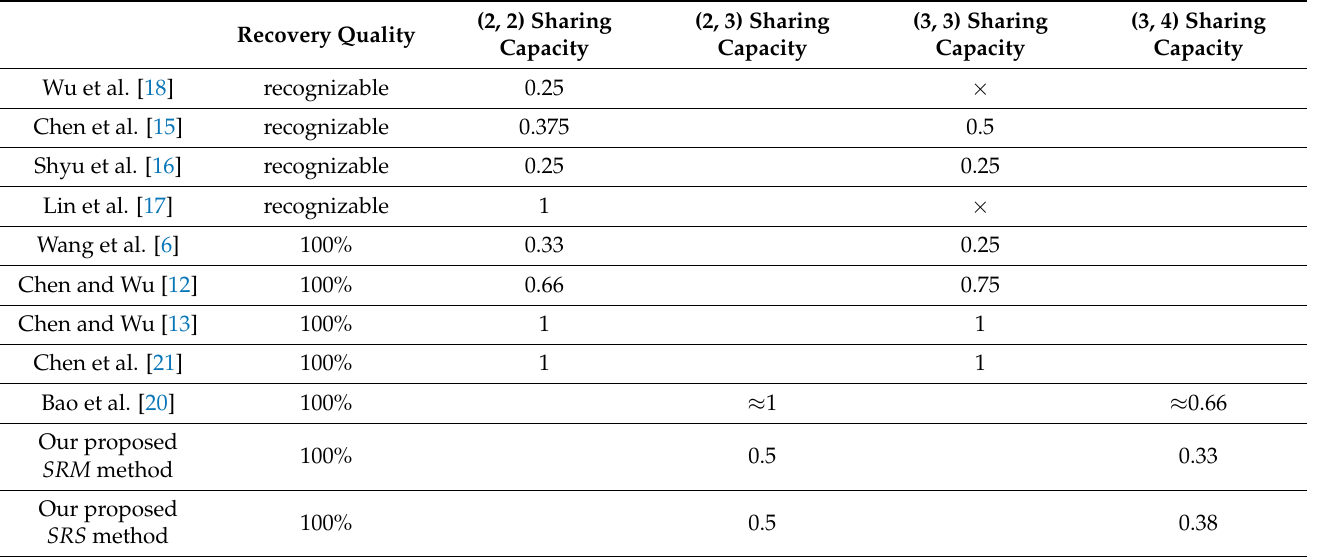
Table 3. Sharing capacity comparisons among the proposed approaches and related multiple secret image sharing